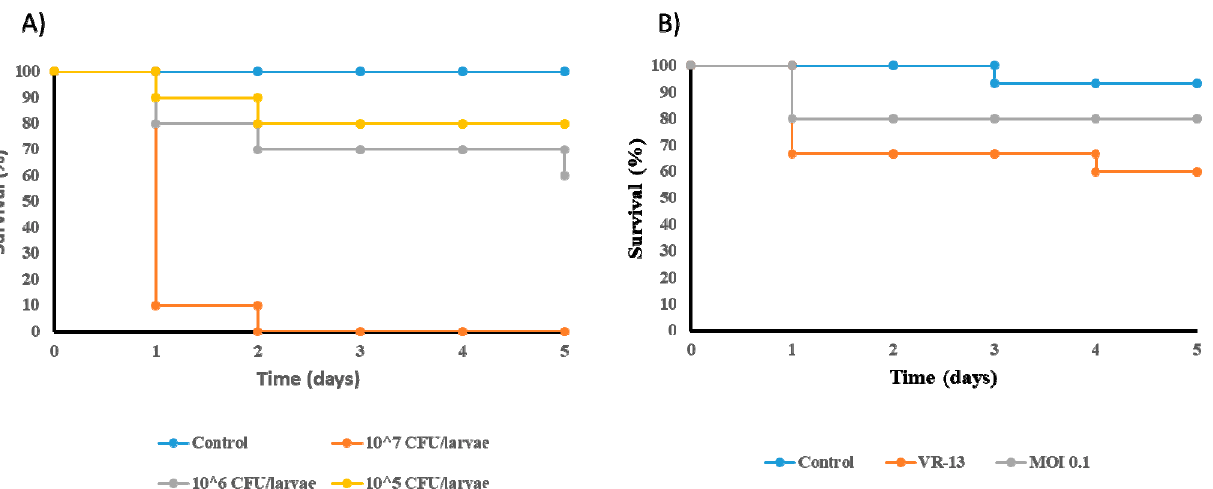
Figure 7. In vivo experiments in Galleria mellonella . A suitable concentration of E. faecium VR-13 per larvae was determined. Control larvae were inoculated with 10 µl of PBS. ( A ) and the effect of the treatment with phage vB_EfmH_163 at MOI = 0.1 ( B ) tested. Control larvae were inoculated with 10 µl of dH 2 O. N = 10 for each experiment and condition.